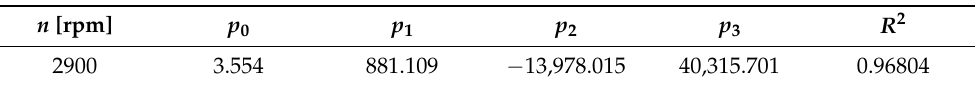
Table 3. The coefficients of the 3rd-degree approximation polynomial function for the pump mechan- ical power P m = f ( Q ) at speed of 2900 rpm.